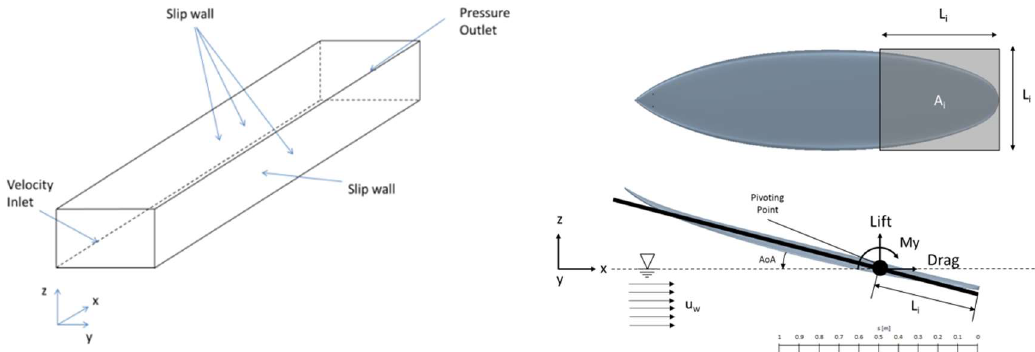
Figure 1. Boundary conditions ( left ) and side and top view of the surfboard models used in the simulations ( right